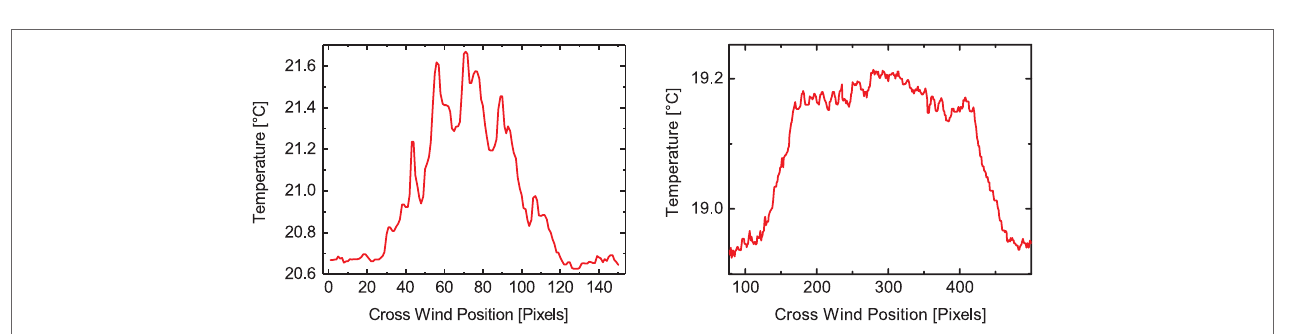
FigURe 15 | Comparison of cross-wind intensity distributions with Nagel’s beam shaping technique (Nagel, 2014) (left) with the current beam shaping technique based on diffractive beam homogenizers